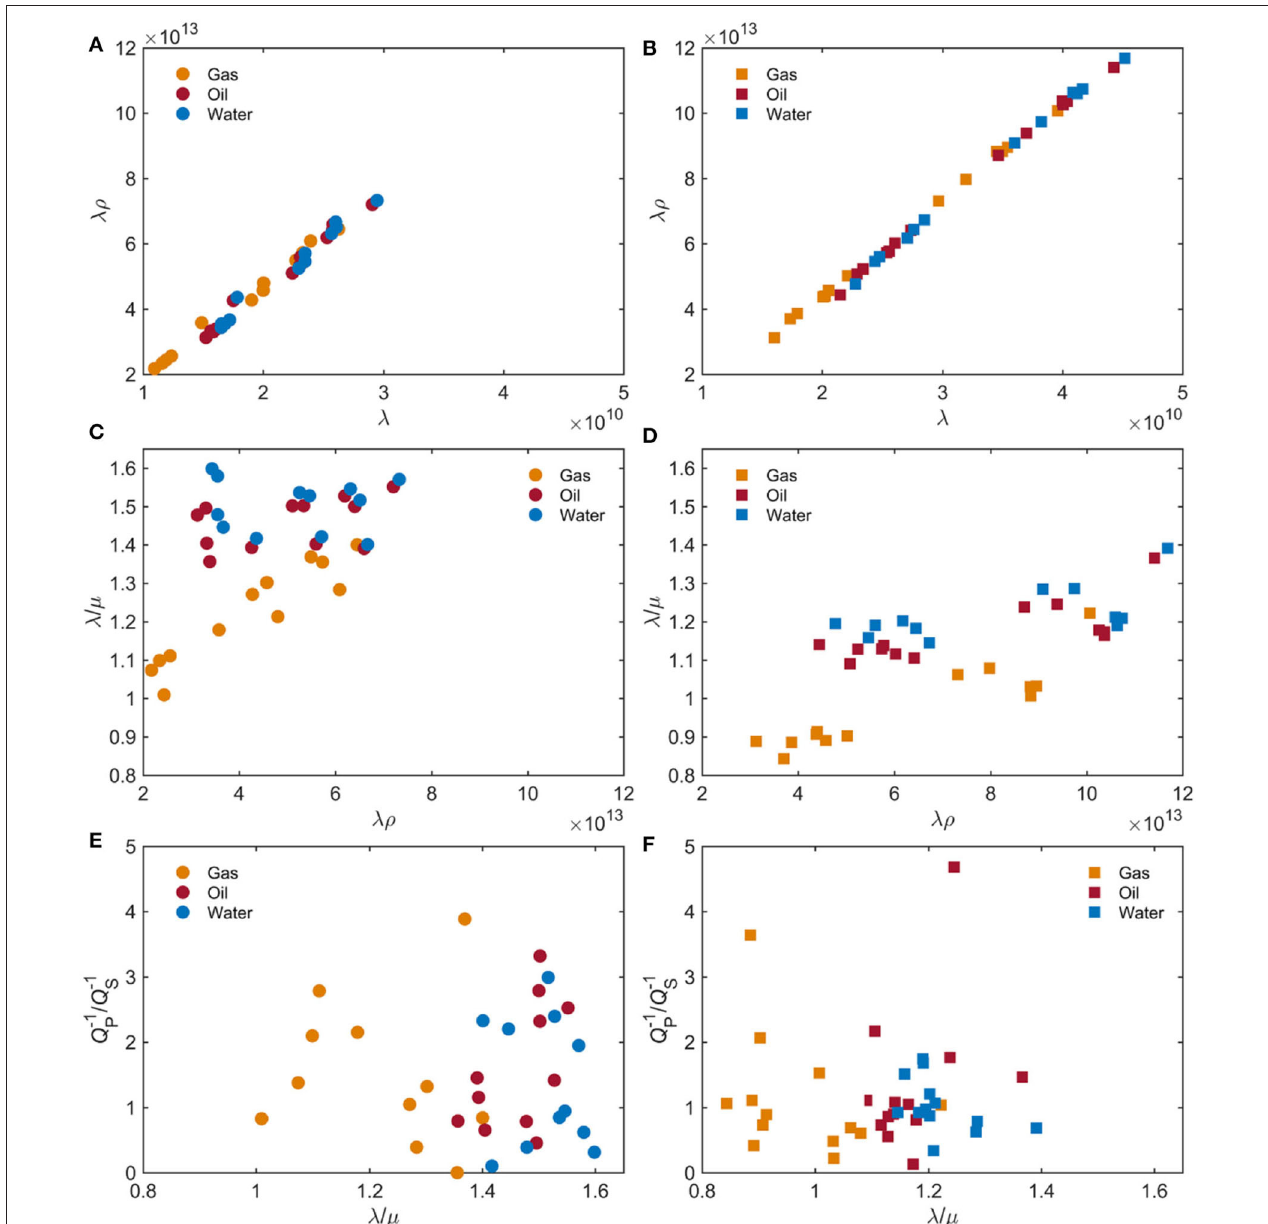
FIGURE 3 | Crossplots of λρ – λ , λ/µ – λρ , and Q − 1 P / Q − 1 S – λ/µ for siltstones (A,C,E) and dolomites (B,D,F) . The brown, red, and blue points denote the data at full gas, oil, and water saturation, respectively. The units of λ and λρ are kg/m 3 × (m/s) 2 and (kg/m 3 × m/s) 2 , respectively.